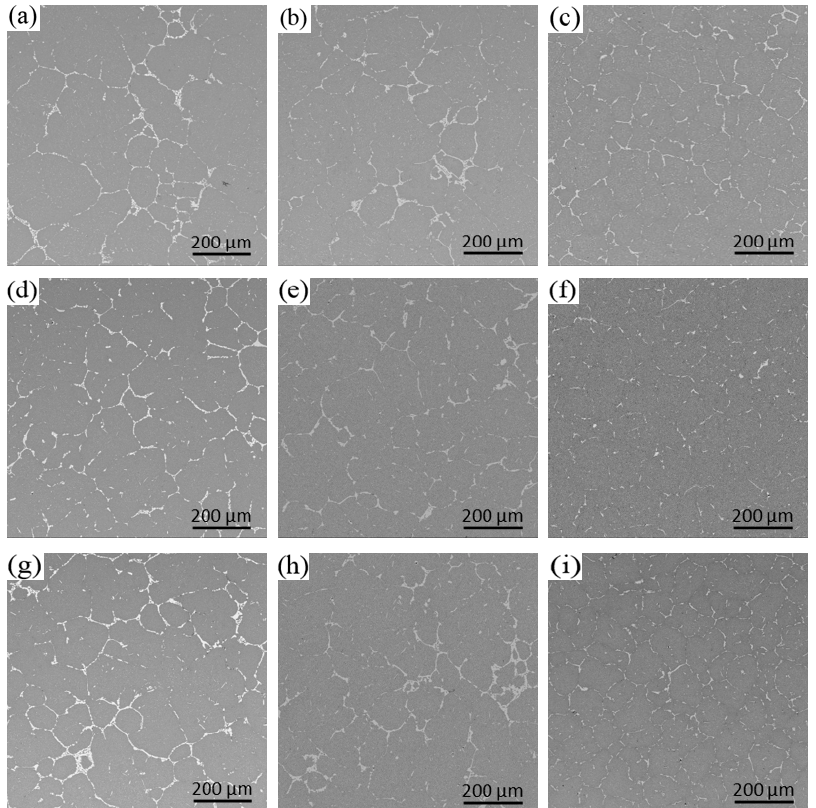
Figure 7. Distribution of the secondary phase of the ingots under different processing conditions: ( a ) Center of ingot without ultrasonic; ( b ) 1/2 radius of ingot without ultrasonic; ( c ) edge of ingot without ultrasonic; ( d ) center of ingot by L-shaped ultrasonic; ( e ) 1/2 radius of ingot by L-shaped ultrasonic; ( f ) edge of ingot by L-shaped ultrasonic; ( g ) center of ingot by straight-rod ultrasonic; ( h ) 1/2 radius of ingot by straight-rod ultrasonic; and ( i ) edge of ingot by straight-rod ultrasonic.